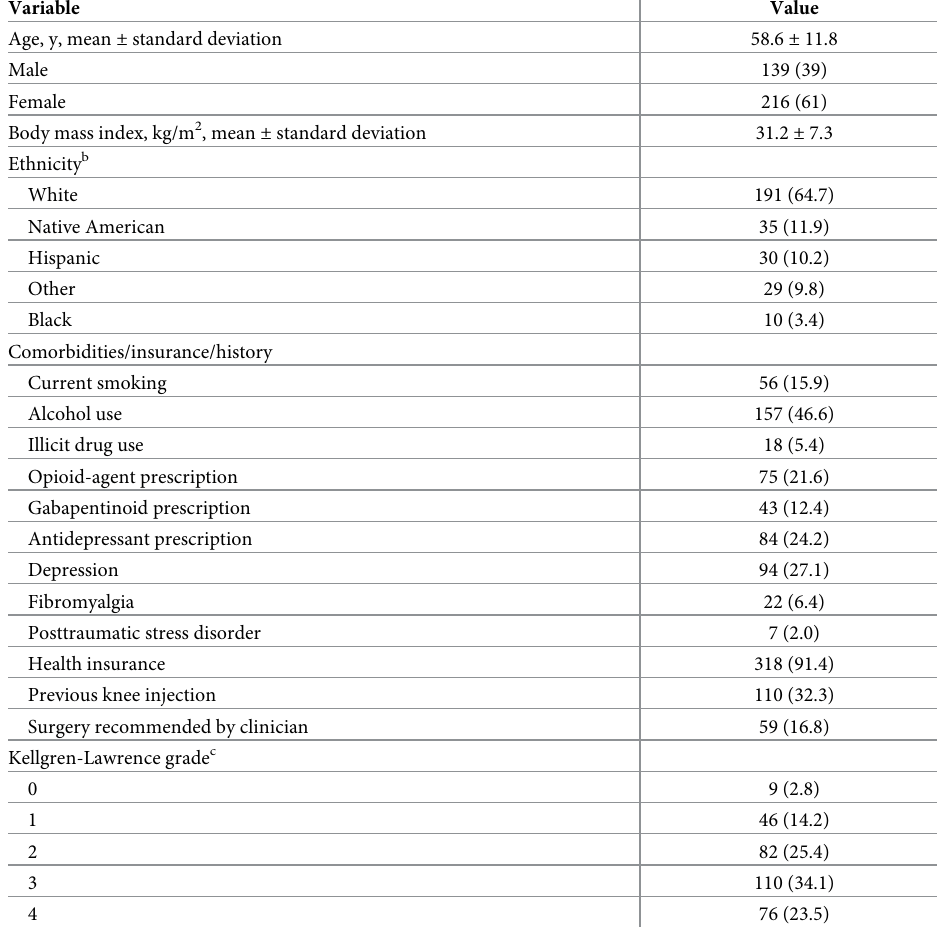
Table 1. Demographic and clinical variables for 355 patients with knee osteoarthritis a .